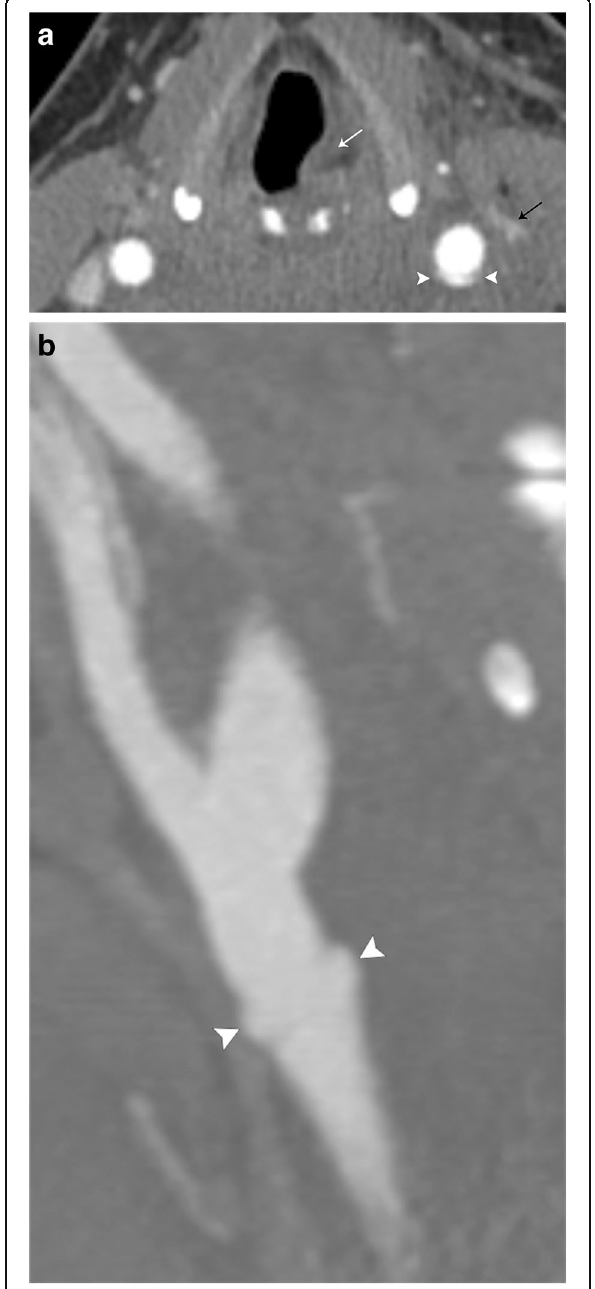
Fig. 14 Traumatic carotid artery pseudoaneurysm. a Axial CT angiogram image demonstrates irregularity of the left common carotid artery (arrowheads) after stab wound to the neck. The left internal jugular vein (black arrow) is also injured. Note medialization (paralysis) of the left vocal fold (white arrow), due to concomitant vagus nerve injury. b Sagittal curved reformatted CT angiogram image better demonstrates the focal pseudoaneurysm (arrowheads) of the left common carotid artery, proximal to the bifurcation